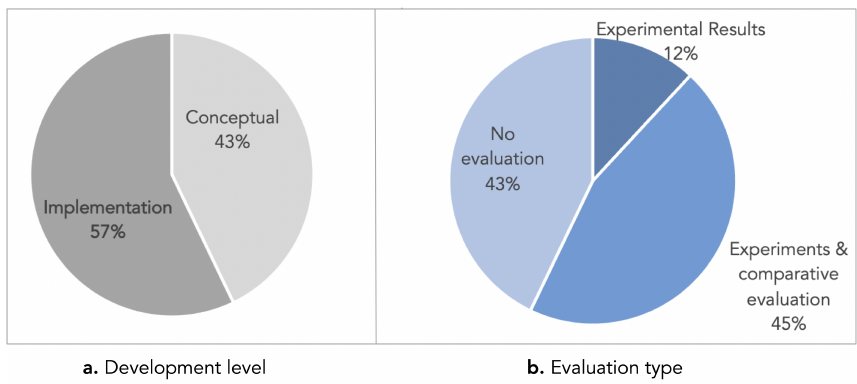
Figure 5. Development and evaluation